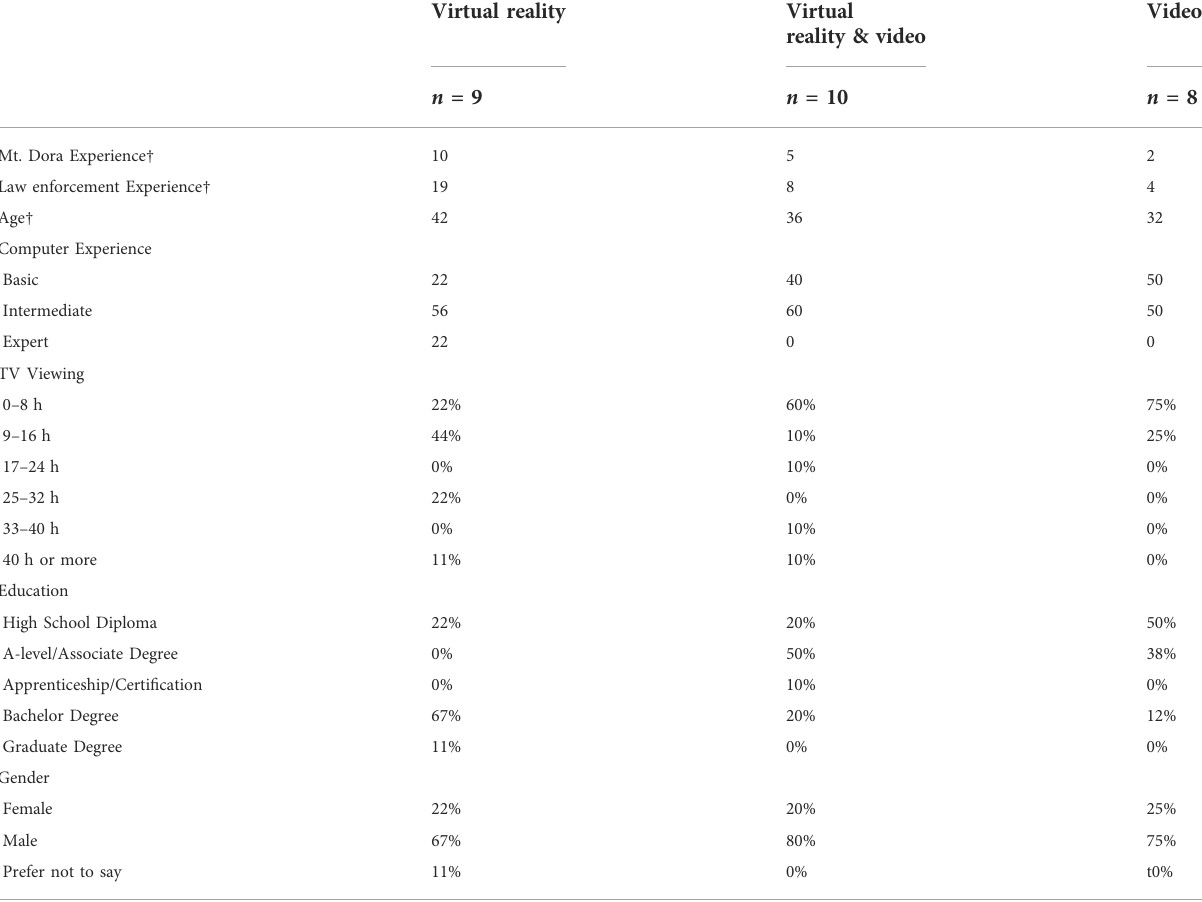
TABLE 1 Demographic statistics for the participants from the Mount Dora Police